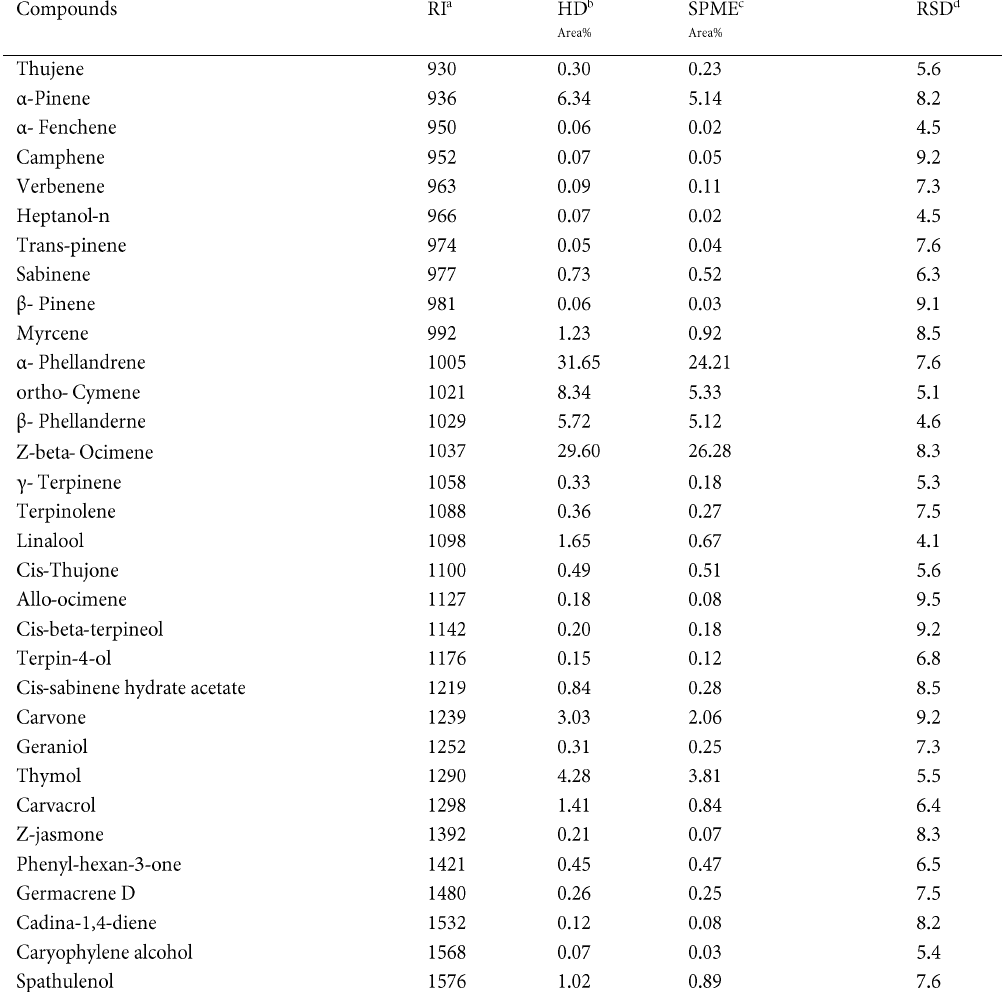
Table 1. Constituents of oil of Satureja hortensis